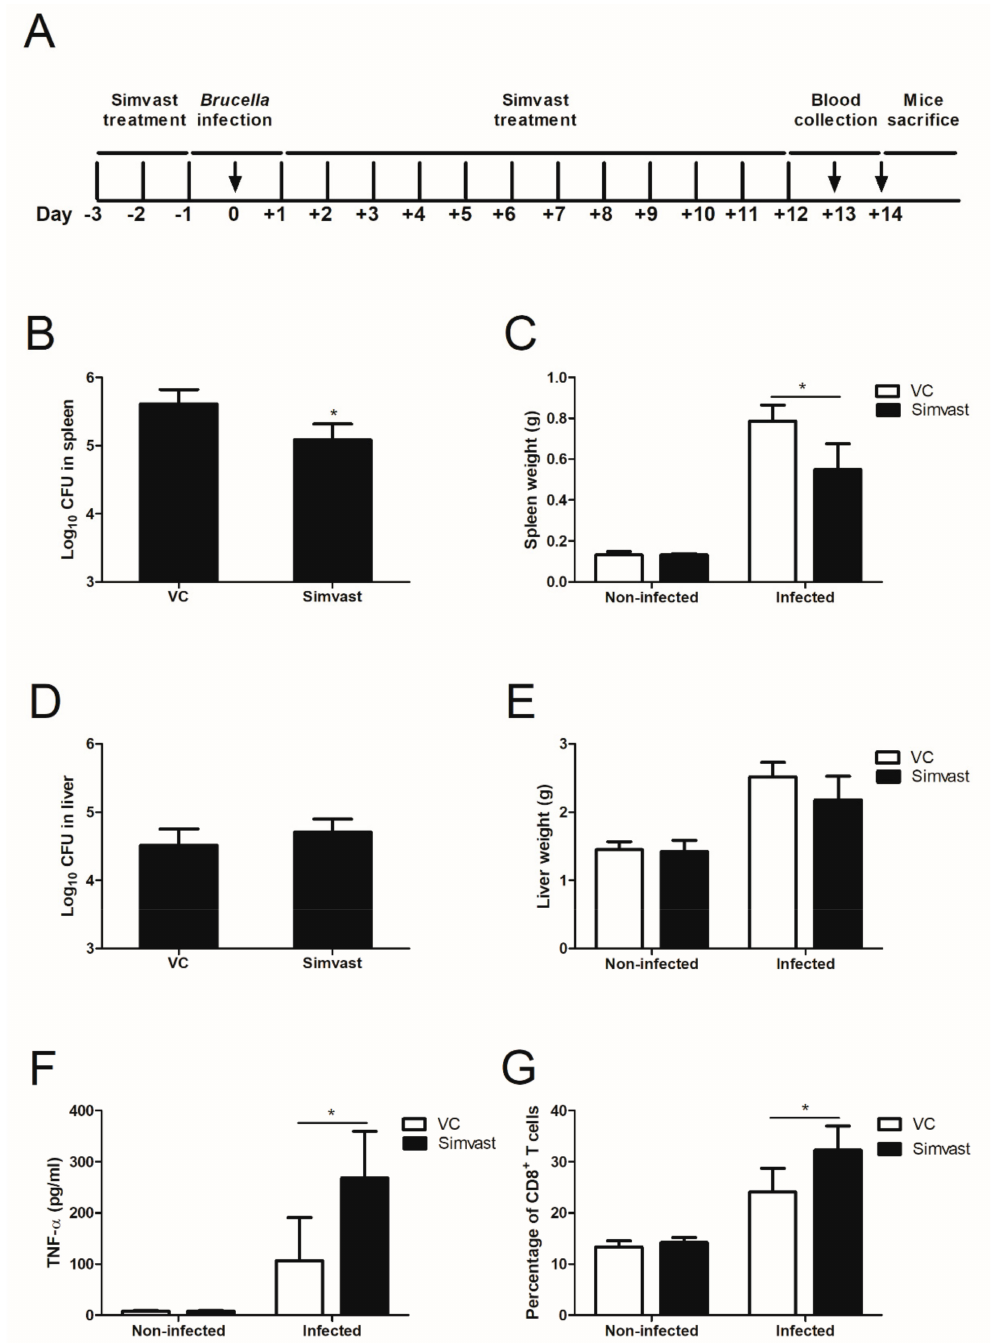
Figure 5. Protection against B. abortus in ICR mice treated with simvastatin. ICR mice were orally treated with 20 mg/kg/day of simvastatin or vehicle control three days prior to infection with B. abortus, and continuously treated following infection until sacrificed as indicated in the diagram ( A ). At day 14 pi, the bacterial load ( B ) and the total weight of the spleen ( C ) were determined. At the same time, the bacterial burden ( D ) and the total weight of the liver ( E ) were also determined. The production of TNF- α cytokine in serum ( F ) and the differentiation of CD8 + T cells ( G ) were analyzed by flow cytometry. The data are represented as the mean ± SD of the mean of each group of five mice. Asterisks indicate statistically significant differences (* p <